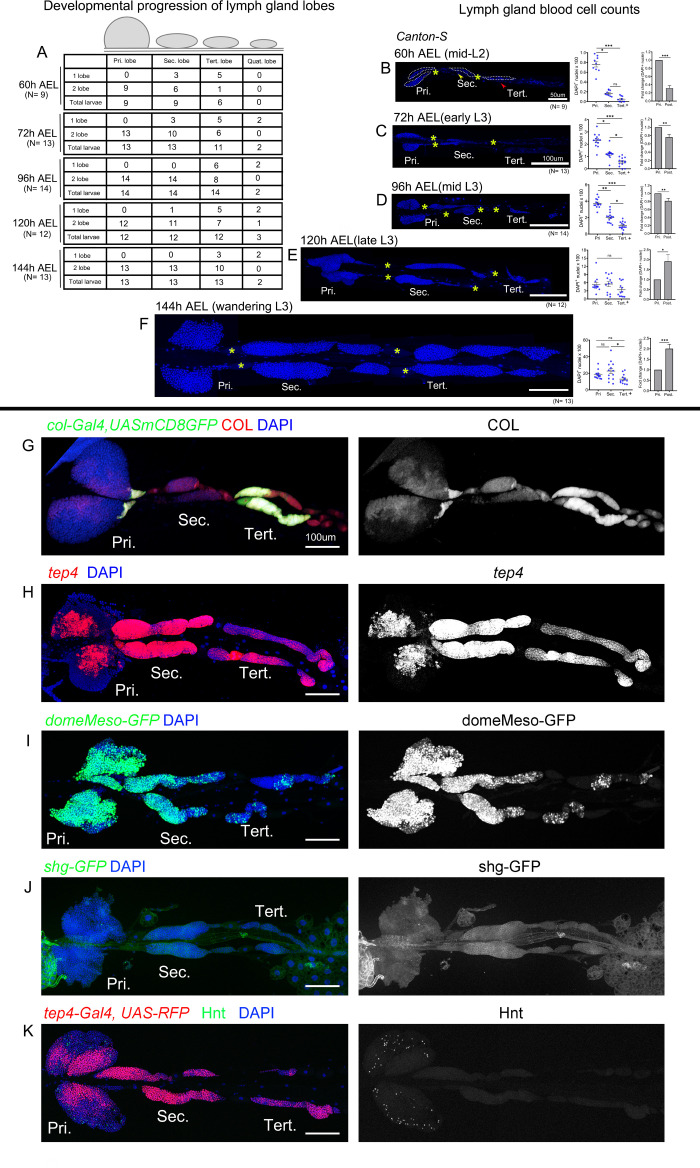
Analysis of lymph gland lobes and gene expression analysis.Whole lymph gland preparations (including primary and posterior lobes [sec., tert., quat. lobes]) are shown. (A) Table shows number of larvae that have one or two primary/secondary/tertiary/quaternary lobes during development at the indicated time points. (B–F) Shows total lymph gland blood cell counts (DAPI+ cells) at 60 hr after egg laying (AEL), 72 hr AEL, 96 hr AEL, 120 hr AEL, and 144 hr AEL, respectively. (B) Yellow and red arrowheads indicate secondary and tertiary lobes. (B–F) Kruskal–Wallis test was used for analysis of DAPI+ cells and for fold-change analysis Student's t-test was used. (G–K) Wandering third instar larvae whole lymph gland preparations showing the expression of (G): col-Gal4,UAS-GFP (green) and Col (red), (H) Tep4 (red), (I) domeMESO-GFP (green), (J) shg-GFP (green), or (K) Tep4-Gal4,UAS-RFP (red) and Hnt (green) as revealed by fluorescent immunostaining (G and I–K) or in situ hybridization (H). Nuclei were stained with DAPI (blue). Pri. indicates primary lobes, Sec. indicates secondary lobes, and Tert. indicates tertiary lobes. (G–K) Right panels: single channel images. Scale bar: (B) 50 µm, (C–K) 100 µm.Figure 1—figure supplement 1—source data 1.Numerical data plotted and statistical analysis related to Figure 1—figure supplement 1.